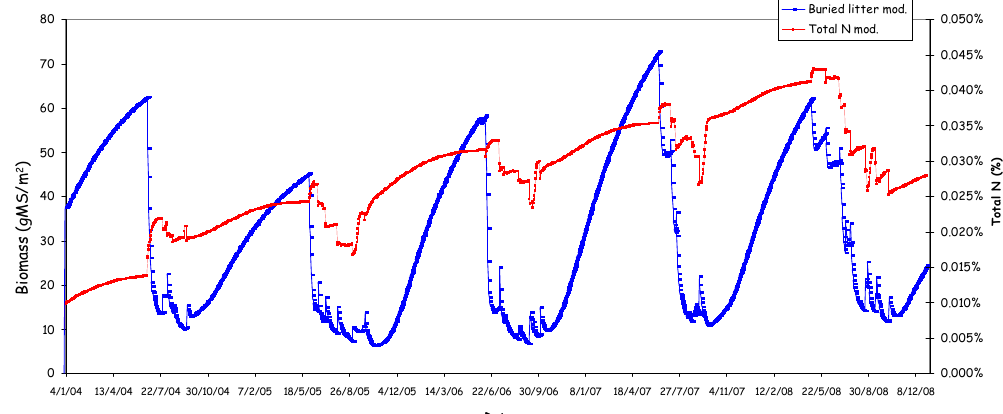
Figure 5. Simulated buried litter in g ( d . m .) m − 2 in dark blue and total N content in the soil in %, for years 2004 to 2008 at Agoufou.